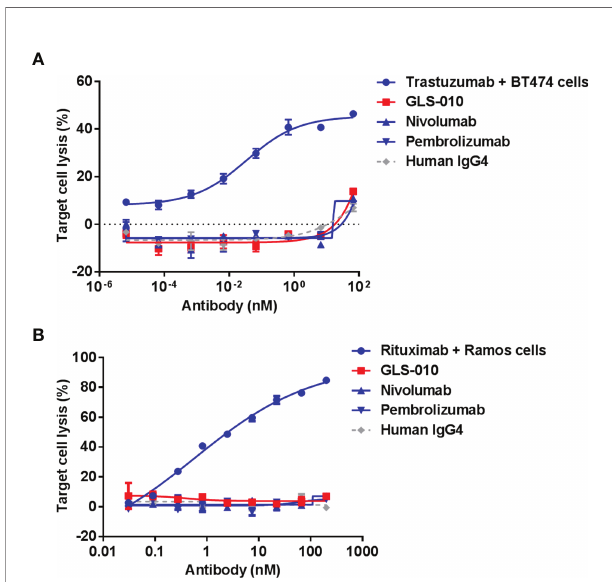
FIGURE 4 | Antibody-dependent cell-mediated cytotoxicity (ADCC) and complement-dependent cytotoxicity (CDC) of anti-PD-1 antibodies. (A) ADCC of GLS-010 and anti-PD-1 control antibodies. (B) CDC of GLS-010 and anti- PD-1 control antibodies.